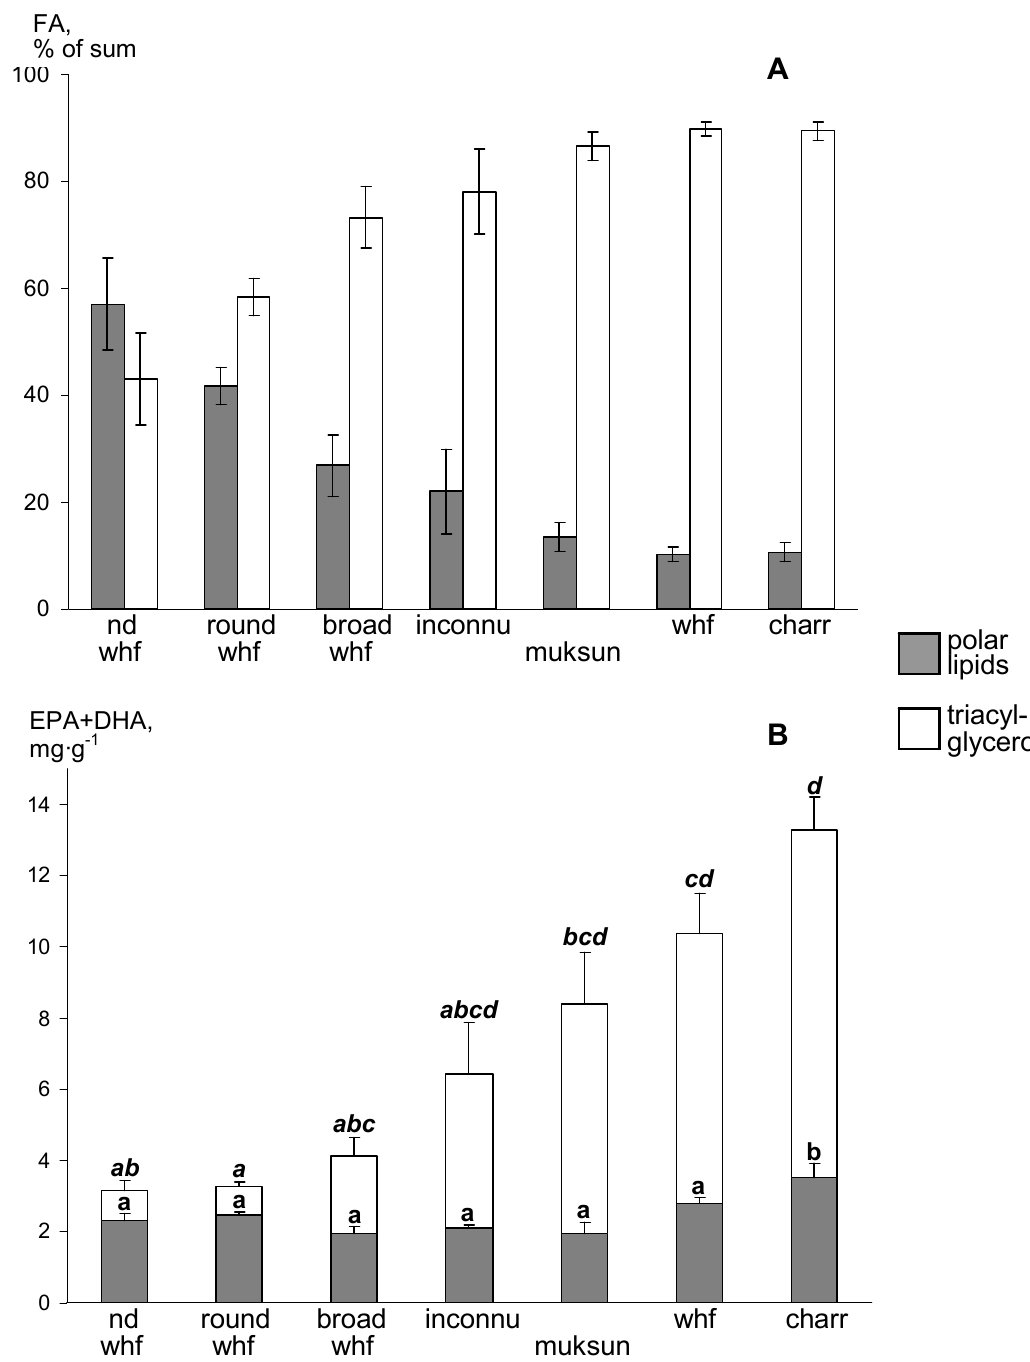
Figure 4. Mean percentages of polar lipids and triacylglycerols of their sum – A , and mean contents (mg g − 1 wet weight) of sum of eicosapentaenoic and docosahexaenoic acids that corresponded to polar lipids and triacylglycerols – B , in muscles of seven fish species from arctic lakes (Siberia, Russia): nd whf – the non ‐ identified form of C. lavaretus from Sobachye Lake, round whf – P. cylindraceum from Sobachye Lake, broad whf – C. nasus from Pyasino Lake, inconnu – S. leucichthys nelma from Pyasino Lake, muksun – C. muksun from Pyasino Lake, whf – C. lavaretus from Sobachye Lake, charr – S. drjagini from Sobachye Lake. Bars represent standard errors. Means labelled with the same letter are not significantly different at p < 0.05 after Tukey HSD post hoc test.